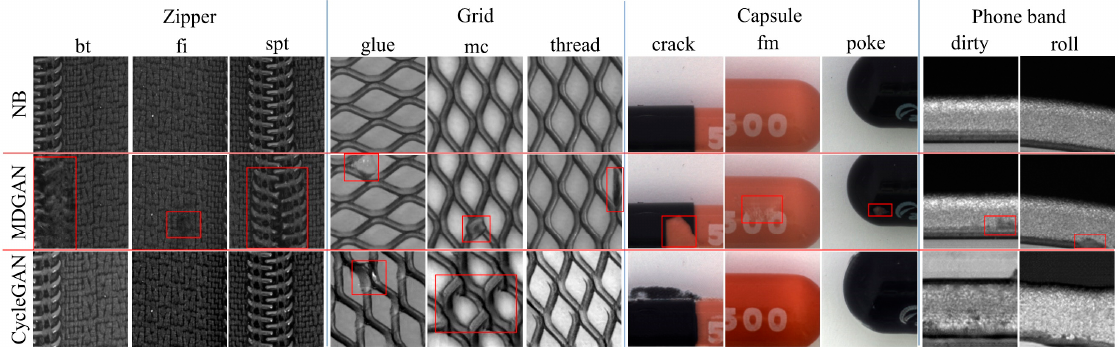
Figure 9. Generated results of MDGAN and CycleGAN with L1 loss based on the same normal backgrounds NB . MDGAN was generated from the NB and a binary mask by MDGAN, and CycleGAN was generated from the NB by CycleGAN. Defects are indicated by red boxes.